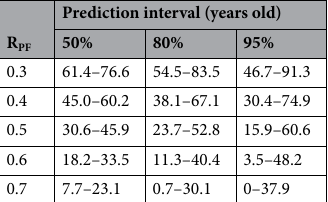
Table 3. R PF and the age prediction intervals for 50, 80 and 95% by confidence levels. R PF: protein-folding intensity.